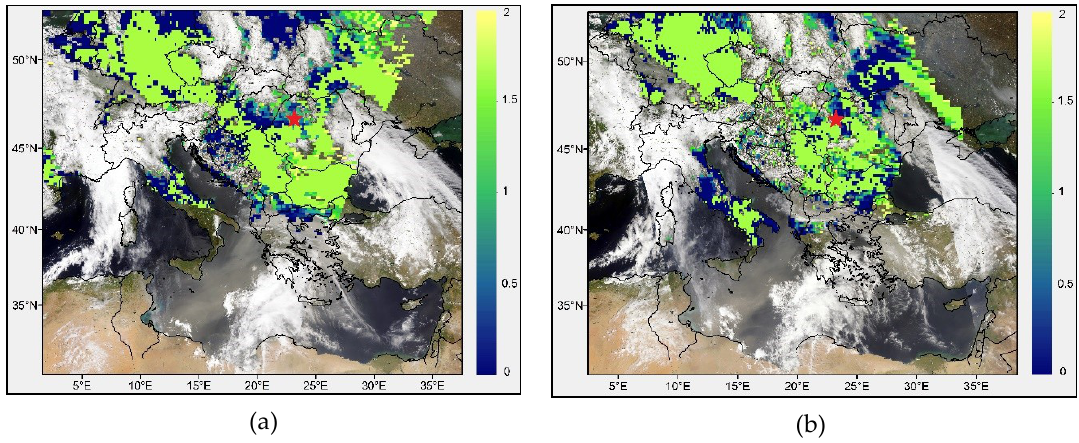
Figure 5. Ångström Exponent MODIS Terra ( a ) and Aqua ( b ) for April the 24 th